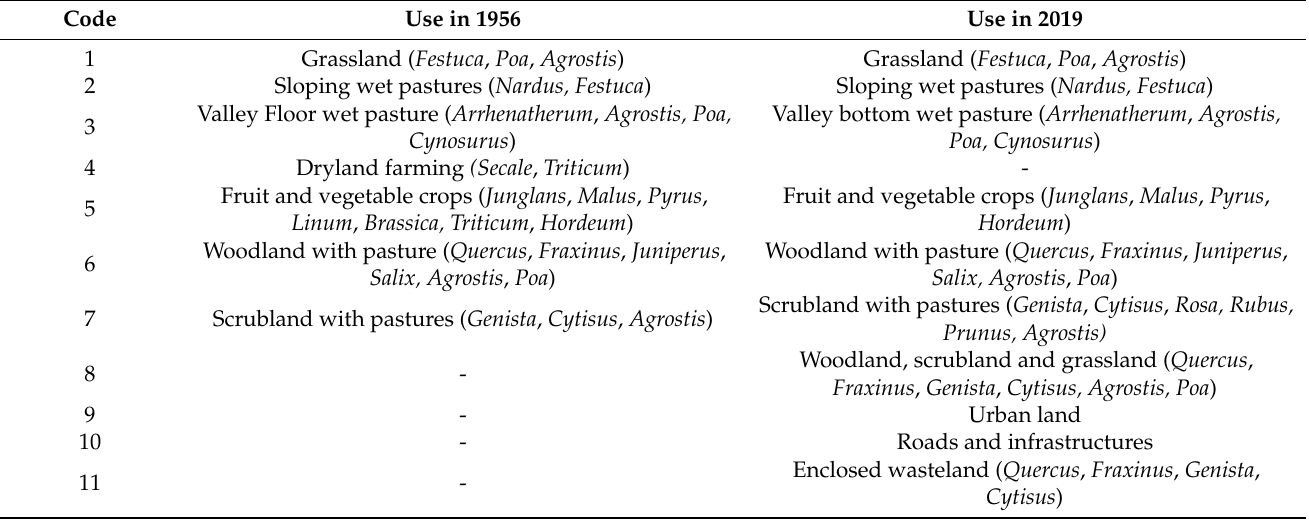
Table 2. Land use categories in 1956 and